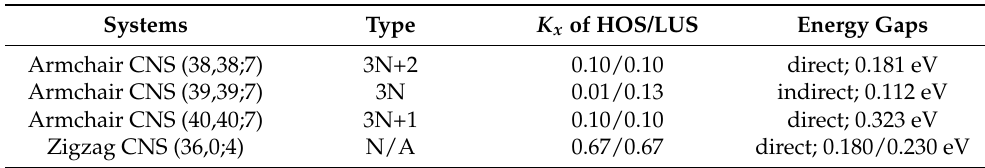
Table 1. The energy gaps, wave vectors of highest occupied state (HOS) and lowest unoccupied state (LUS), and the 3N type of various systems.